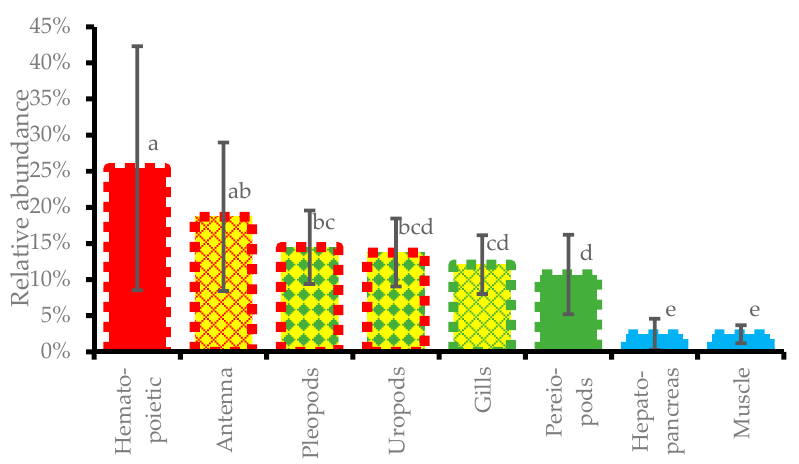
Figure 5. Relative abundance of DIV1 for different tissues of fifteen DIV1-infected M. rosenbergii samples. Columns without sharing of a same letter indicate significant difference of p < 0.05; columns without a same color indicate a highly significant difference of p < 0.01.